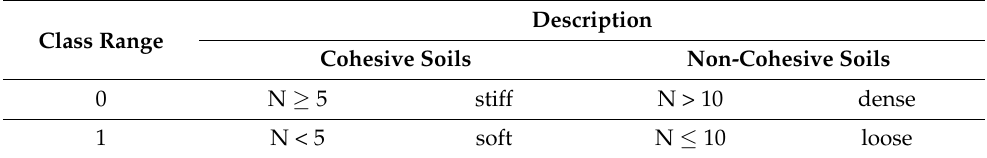
Table 10. Criteria for classification in step 2.